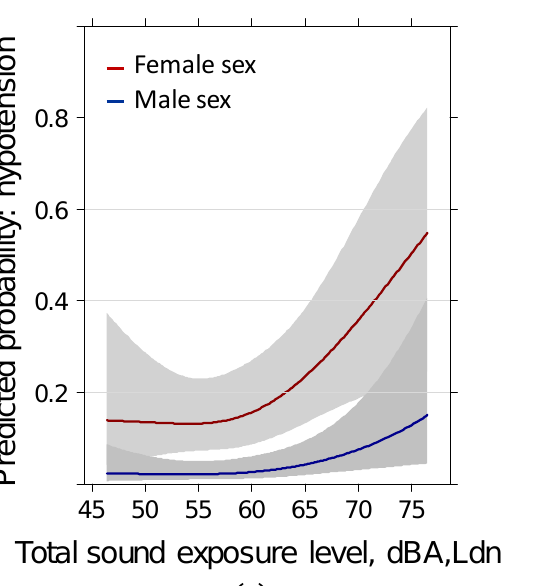
Figure 1. Predicted probability of reported hypotension past year with total sound level exposure by ( a ) sex and ( b ) weather sensitivity. Models are adjusted for age, education, anti-hypertensive treatment, family history of hypertension, health status, sleep score, distance to main road, annoyance by local roads, region and the IA-terms age × sex, weather sensitivity × health, weather sensitivity × sound exposure, distance × sound exposure and annoyance × sound